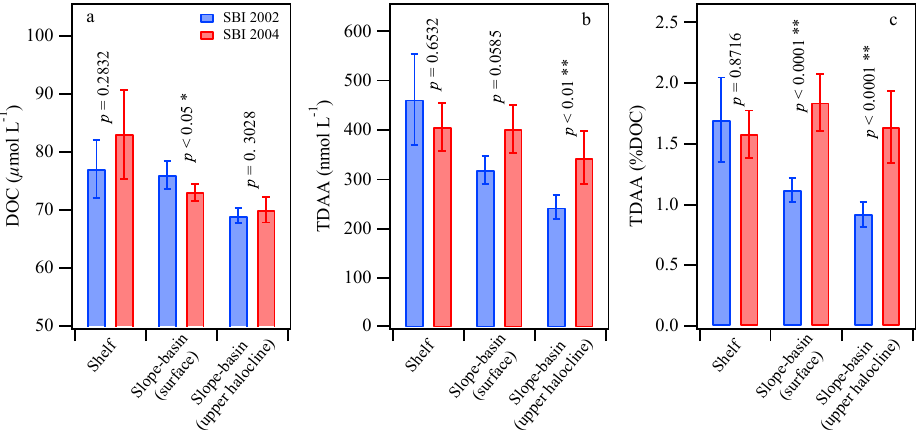
Fig. 7. Temporal comparisons of average concentrations of (a) dissolved organic carbon (DOC) and (b) total dissolved amino acids (TDAA), and (c) yields of TDAA in shelf, slope, and basin waters between SBI 2002 and 2004. Error bars represent two times the standard error. Significant ( p < 0 . 05) and highly significant ( p < 0 . 01) differences are marked with one and two asterisks, respectively.